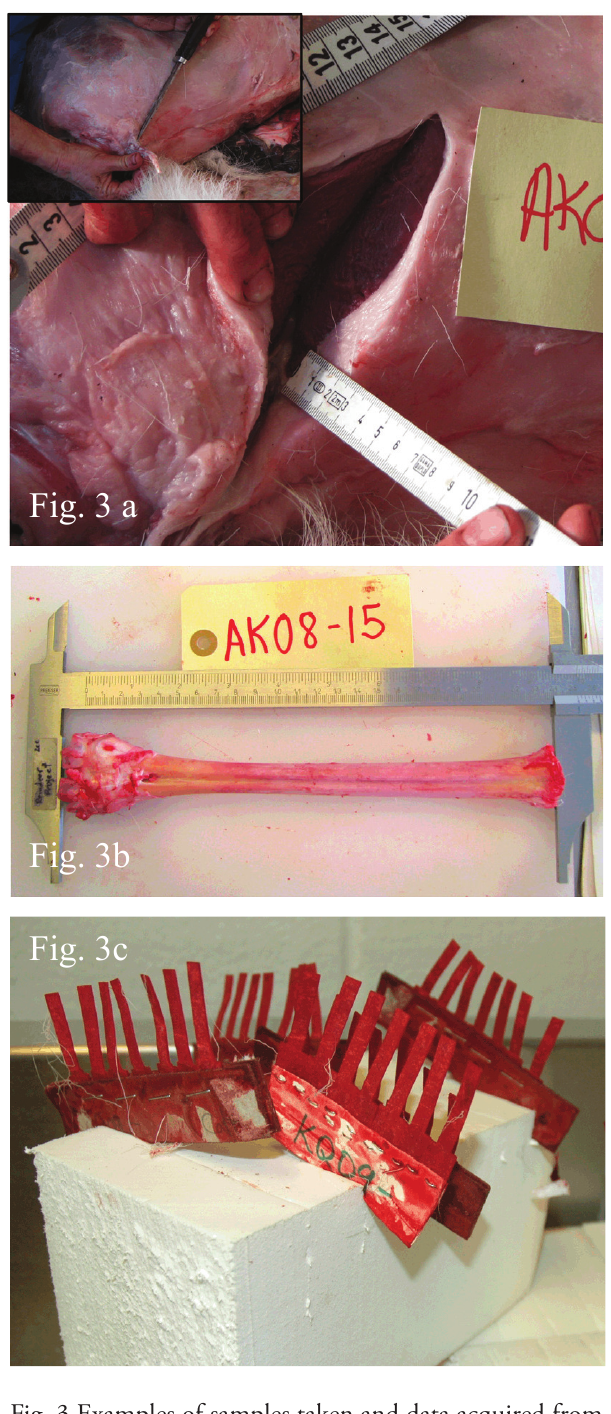
Fig. 3 Examples of samples taken and data acquired from caribou sampling activities. (a) Back fat depth is measured at a 45 o angle from the base of the tail (see inset) with a measuring tape, a ruler, or the tag (see Fig. 2a). Backfat is measured at the deepest point. (Image credit: Wendy Nixon). (b) Metatarsal bone length measured by calipers (Image credit: Wendy Nixon). (c) Drying of Nobuto® fil- ter paper strips that have been dipped in clean blood (Im- age credit: Karin